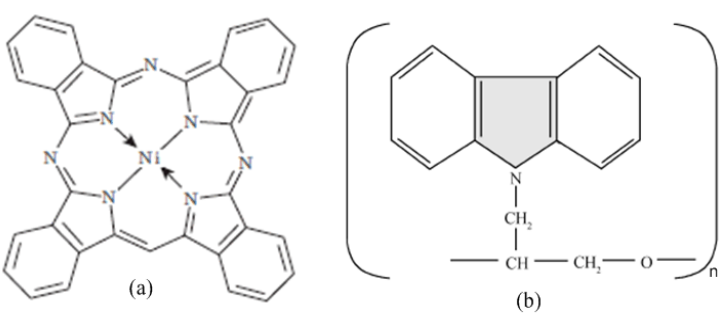
O-PEPC-NiPC thin film at 1K and 2